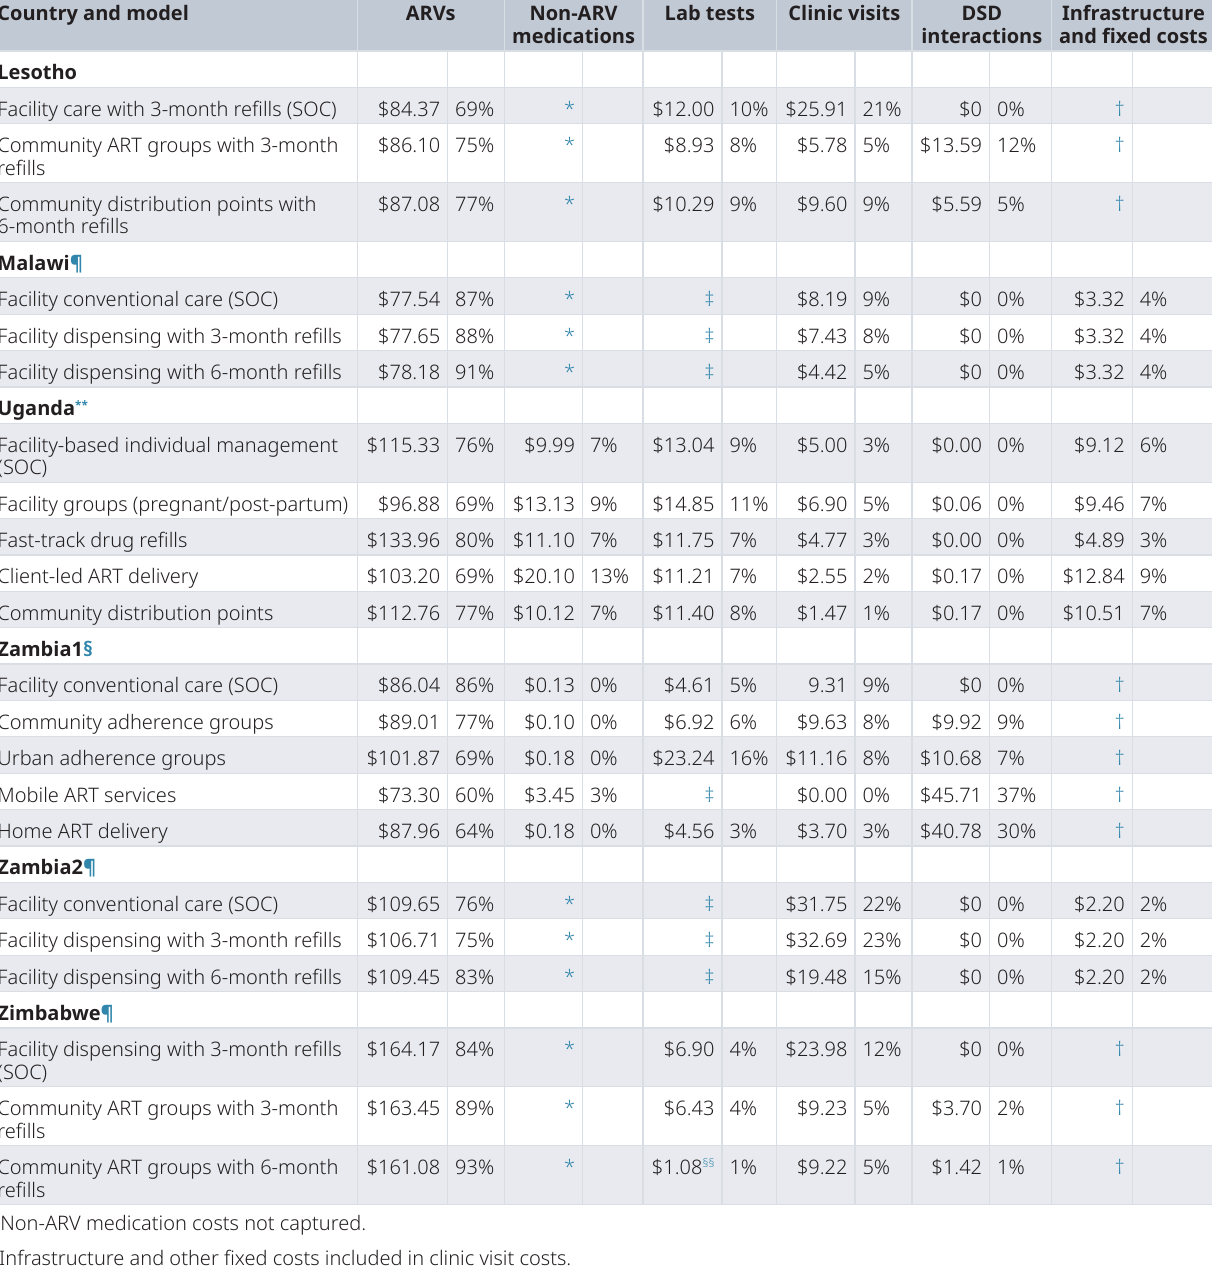
Table 5. Breakdown of cost per patient at 12 months, by model (cost and percentage of total mean cost/patient). Country and